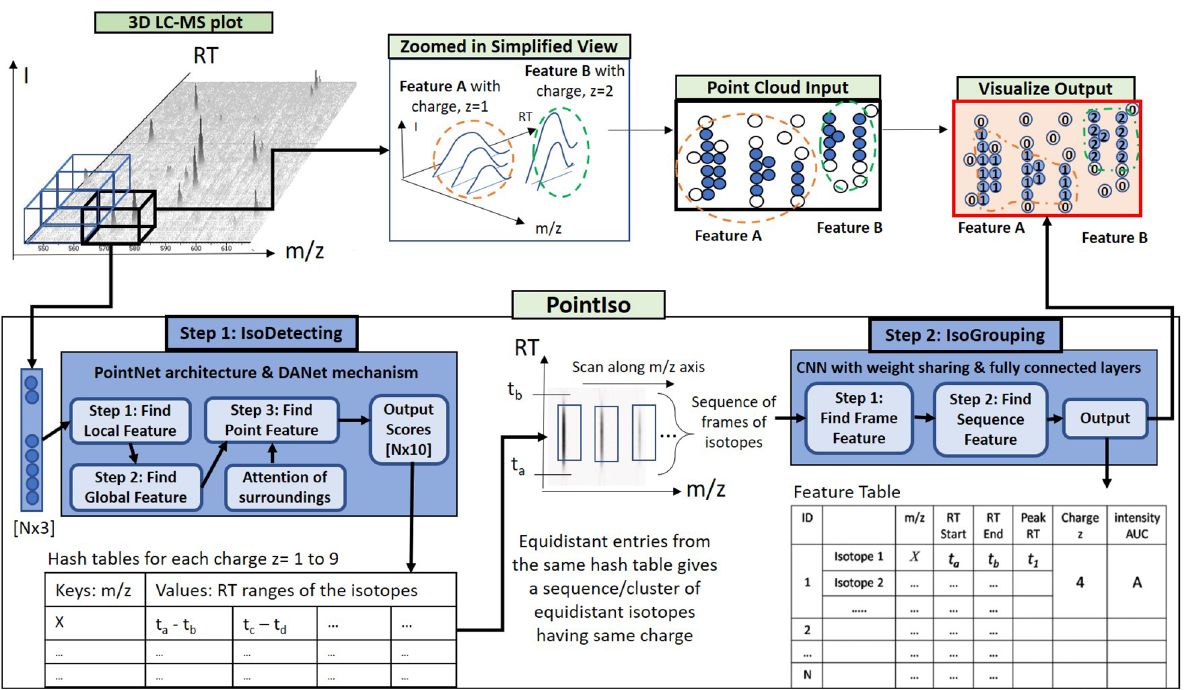
This region is further shown in the next image, labeled as ‘Zoomed in Simplified View’. Here, two features A and B are shown using orange and green boundary. The corresponding point cloud version of this window is